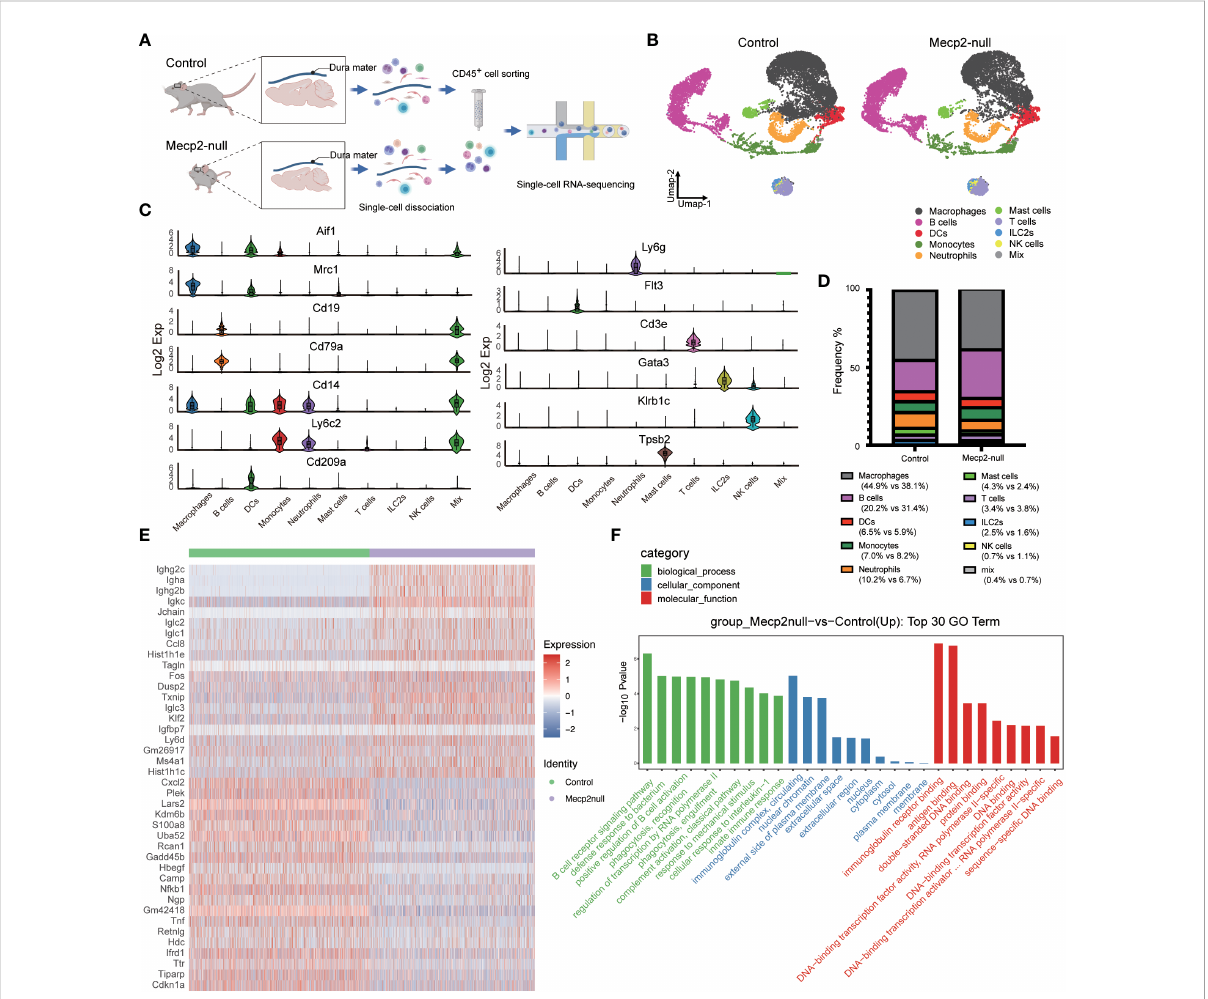
FIGURE 2 Single-cell transcriptomics survey of dura immune cells from WT and Mecp2-de fi cienct mice. (A) Schematic of the experimental approach (created with Biorender.com). 10× chromium scRNA-seq for CD45 + immune cells isolated from dura maters of 1-month-old WT (control) and Mecp2-de fi cienct ( Mecp2 -null) mice. (B) Umap plot displaying 10 dura immune cell types from control and Mecp2 -null mice. Colored show annotated cell types. (C) Violin plots showing the expression levels of 13 speci fi c marker genes for different cell types. (D) Frequency of each cell type in control and Mecp2 -null mice. (E) Heatmap of group-speci fi c DEGs. Color indicates relative gene expression, with representative genes shown together. (F) The top 30 most enriched GO terms for DEGs in control and Mecp2 -null